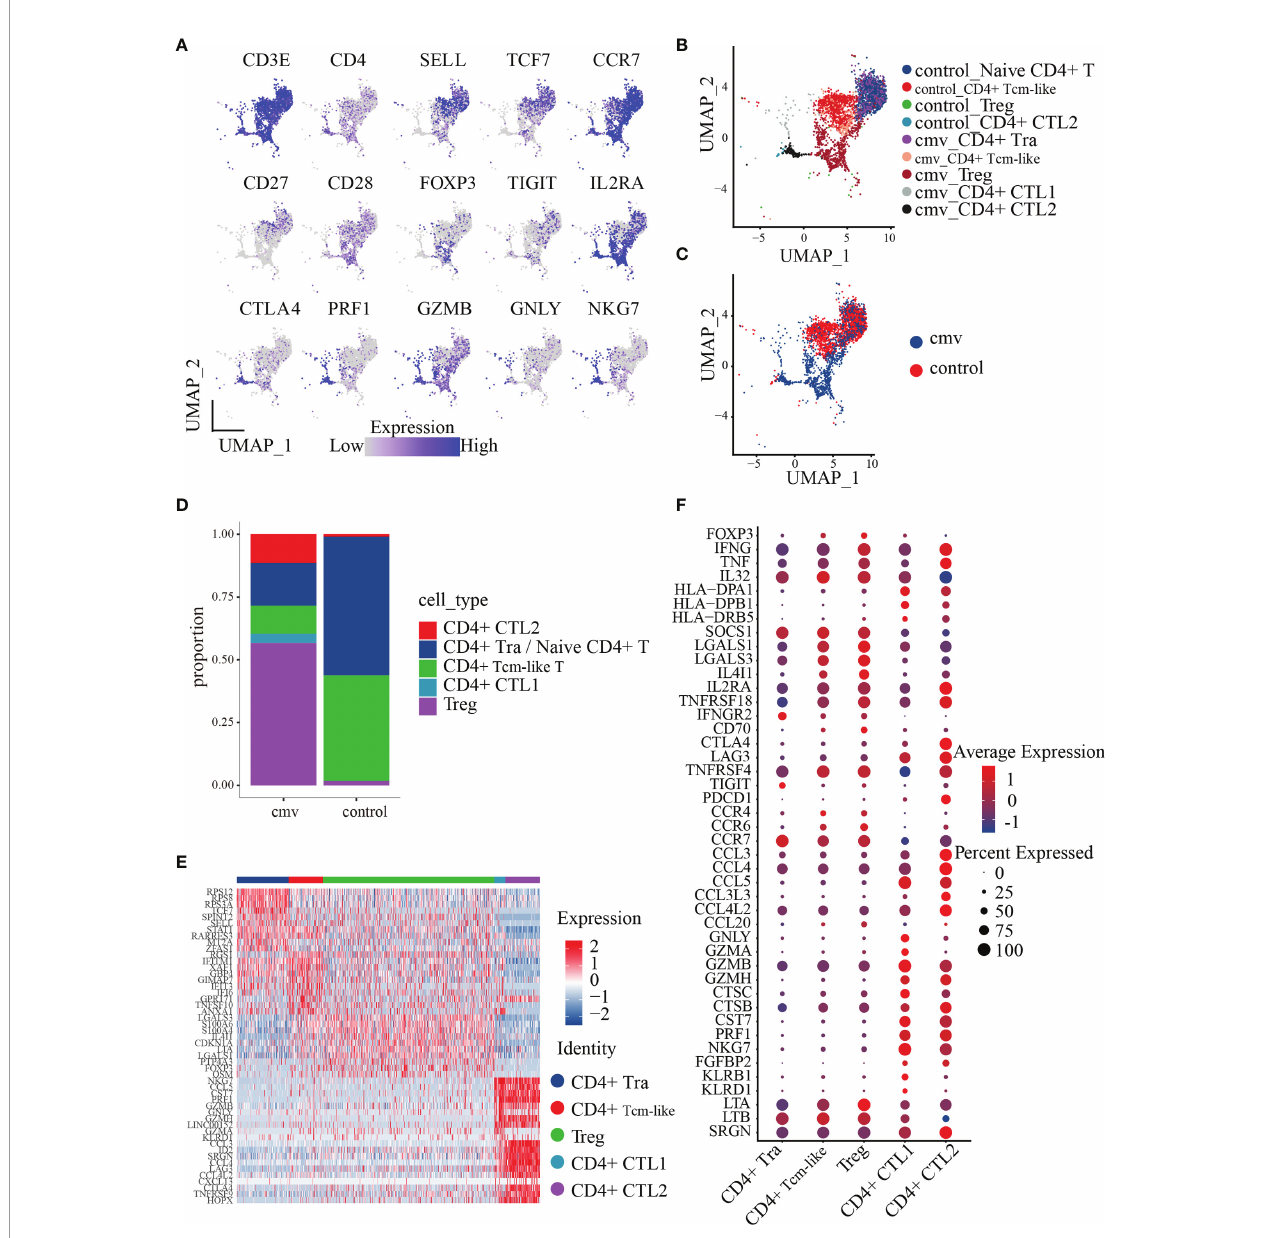
FIGURE 2 | Polyfunctionality pro fi les of CMV pp65-stimulated CD4+ T cell subsets. (A) UMAP projections for the merged CD4+ T cells colored by expression of the naïve CD4+ T/Tcm-like cell markers CD3E , CD4 , SELL , TCF7 , CCR7 , CD27 , and CD28 ; Treg markers FOXP3 , IL2RA , and TIGIT ; the cytotoxicity markers GZMB , NKG7 , and PRF1 . Relative expression was normalized across CMV and control datasets. (B, C) UMAP embeddings of merged scRNA-seq pro fi les from control and stimulated (CMV) CD4+ T cells plotted and colored by cell cluster (B) and sample (C) . Subpopulations of CD4+ T cells colored in (B) were identi fi ed by the canonical markers described in Table 2 . (D) Distribution of the abundance of the subsets of CMV and control CD4+ T cells. (E) Heat map of the fi ve subsets of CMV CD4+ T cell cells with the Top10 DEGs between each pair. (F) Dot plot of highly featured genes expressed in the fi ve CD4+ T cell subsets in